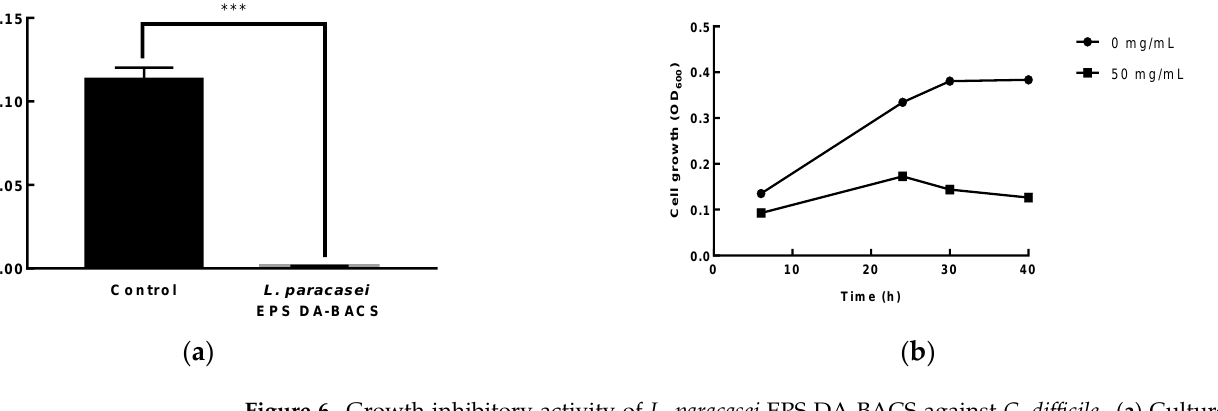
Figure 6. Growth inhibitory activity of L. paracasei EPS DA-BACS against C. difficile . ( a ) Culture supernatant of L. paracasei EPS DA-BACS was added to C. difficile culture; ( b ) 50 mg/mL of purified EPS was added to C. difficile culture. Asterisks show significant differences among groups at ***, p < 0.001 ( n ≥ 3) using one-way ANOVA and Dunnett’s test.